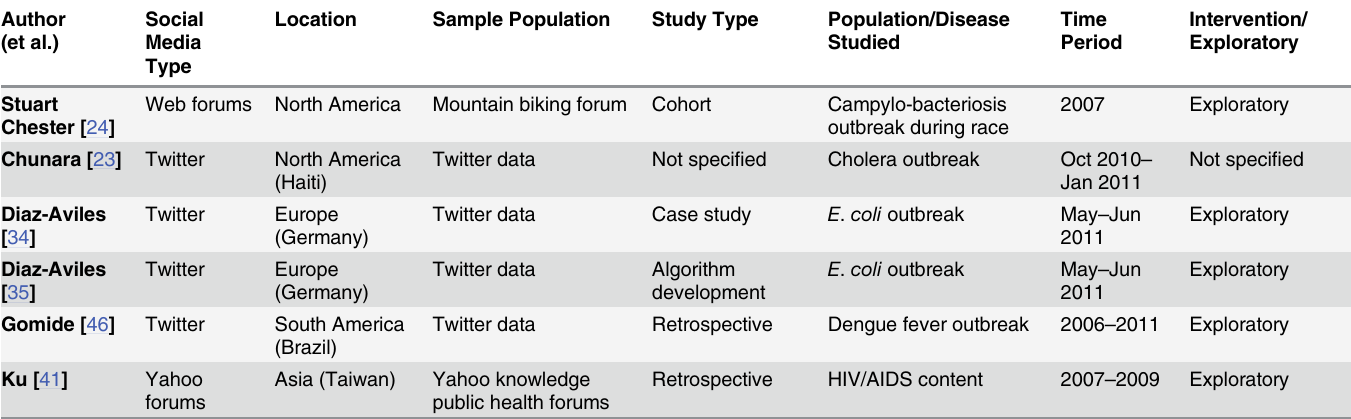
Table 4. Characteristics of 6 infectious disease studies addressing research question 1 a .